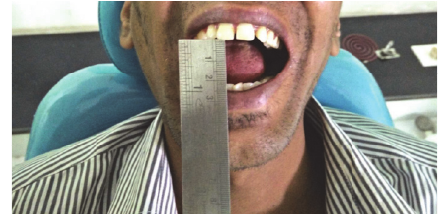
Figure 1: Preoperative MO—22mm.